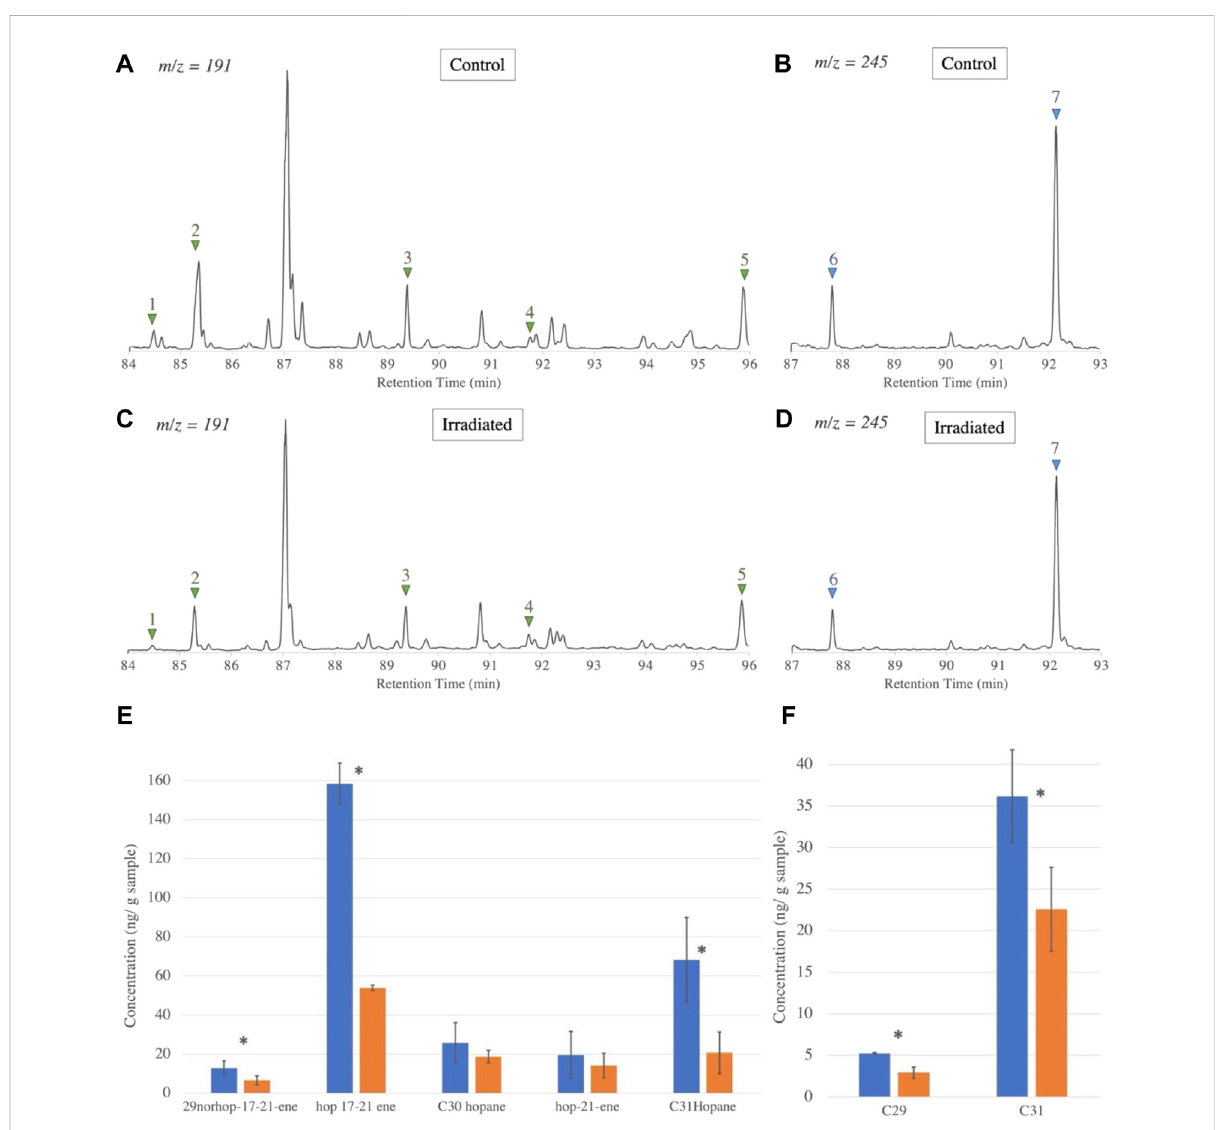
FIGURE 2 Enspel biomarkers chromatogram ion extracts and corresponding concentrations before and after irradiation. Identi fi ed hopanes [ (A,C) , m/z = 191)] and methyl-steranes [ (B,D) , m/z = 245)], before (A,B) and after (C,D) irradiation. Hopanes indicated by a green triangle: (1) 29norhop-17 (21)- ene, (2) hop-17 (21)-ene, (3) C 30 hopane, (4) hop-21 (22)-ene, (5) C 31 hopane. Steranes indicated by a blue triangle: (6) dimethyl cholestane (C29), (7) C 31 sterane. (Structures detailed in Supplementary Figure S1). Concentration of hopanes (E) and steranes (F) before (blue) and after irradiation (orange). Error bars take into account instrumental error and natural variation of organic content in the samples (irradiated, extracted and measured in triplicates). Concentrations in ng molecule per g of sample. The star shows a signi fi cant difference between irradiated and control values ( t test p -value <